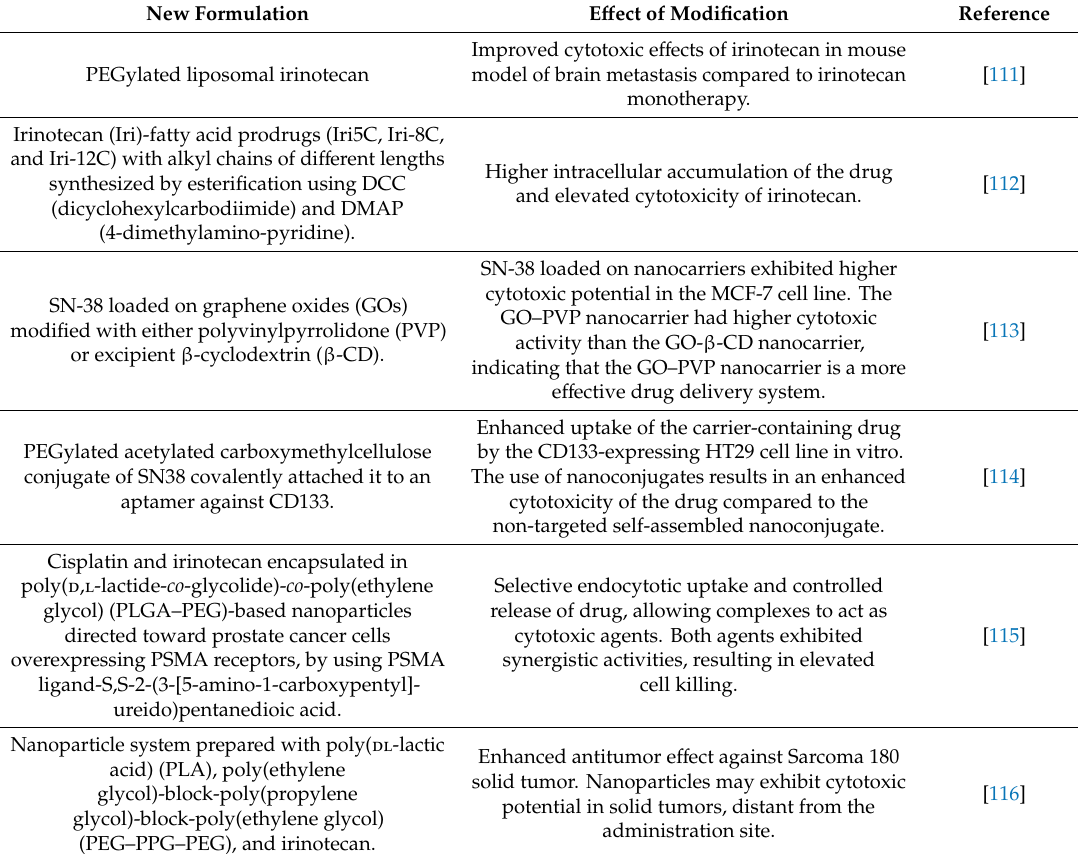
Table 2. New irinotecan formulations with e ff ects of modifications and references. New